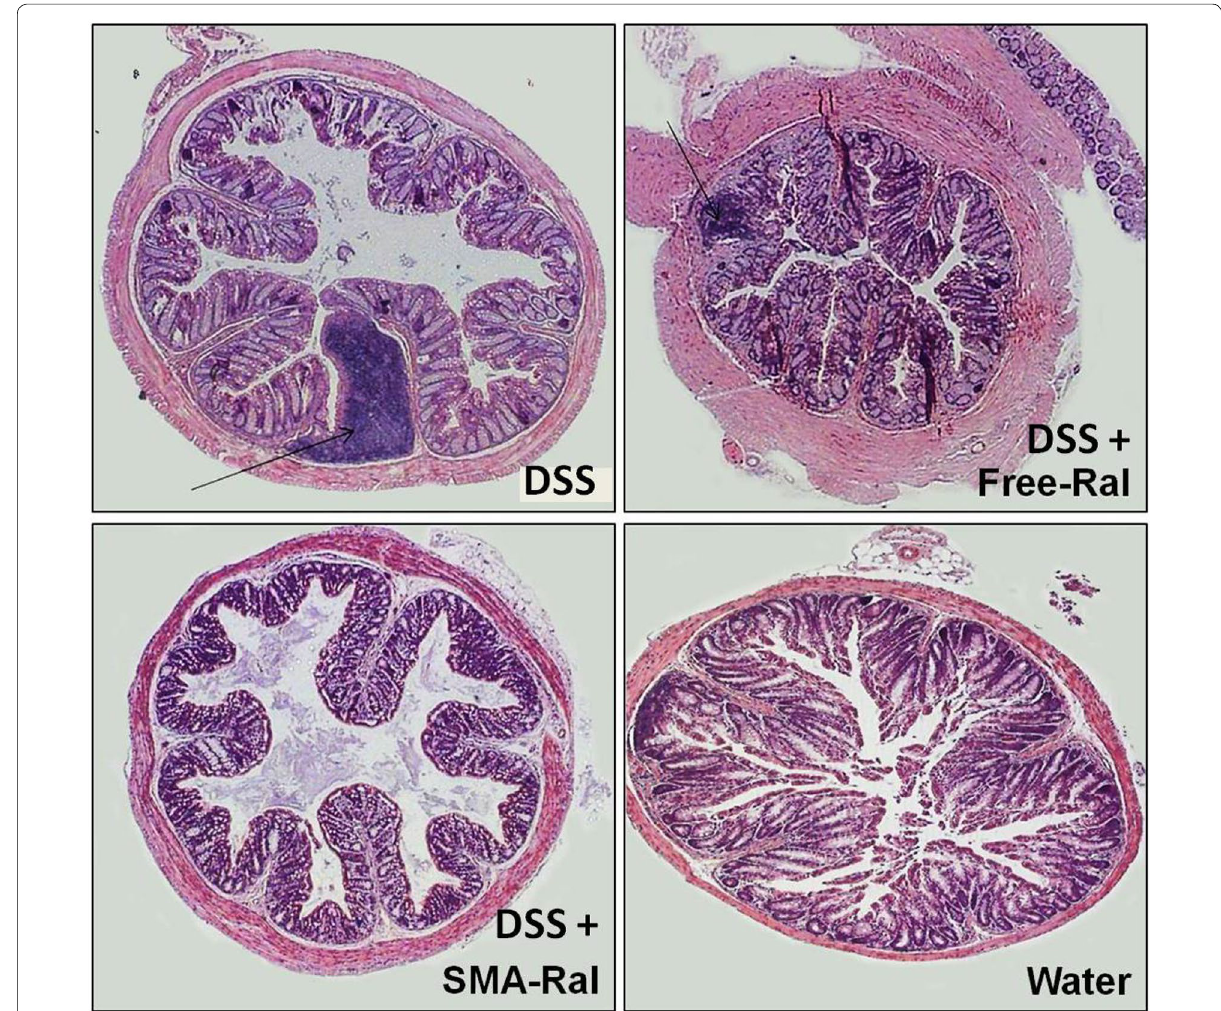
Fig. 5 Distal colon sections ( 10, scale bar 500 µm) showing the histological features of the differently treated mice groups. Arrows point to inflam- × matory